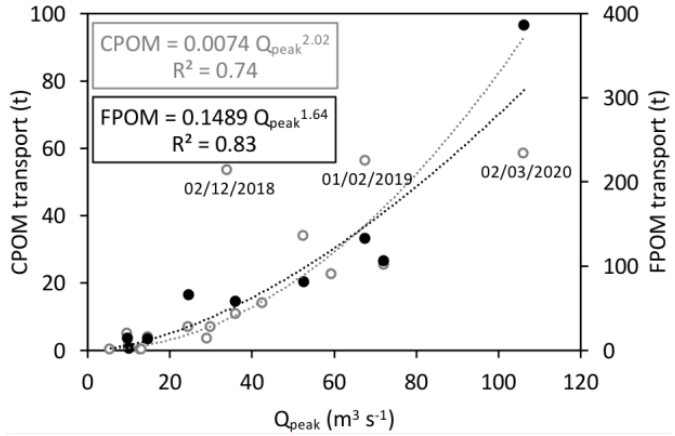
Figure 6. CPOM (grey open dots) and FPOM (black dots) transport (t) during high flow events in relation to maximum discharge (Qpeak).